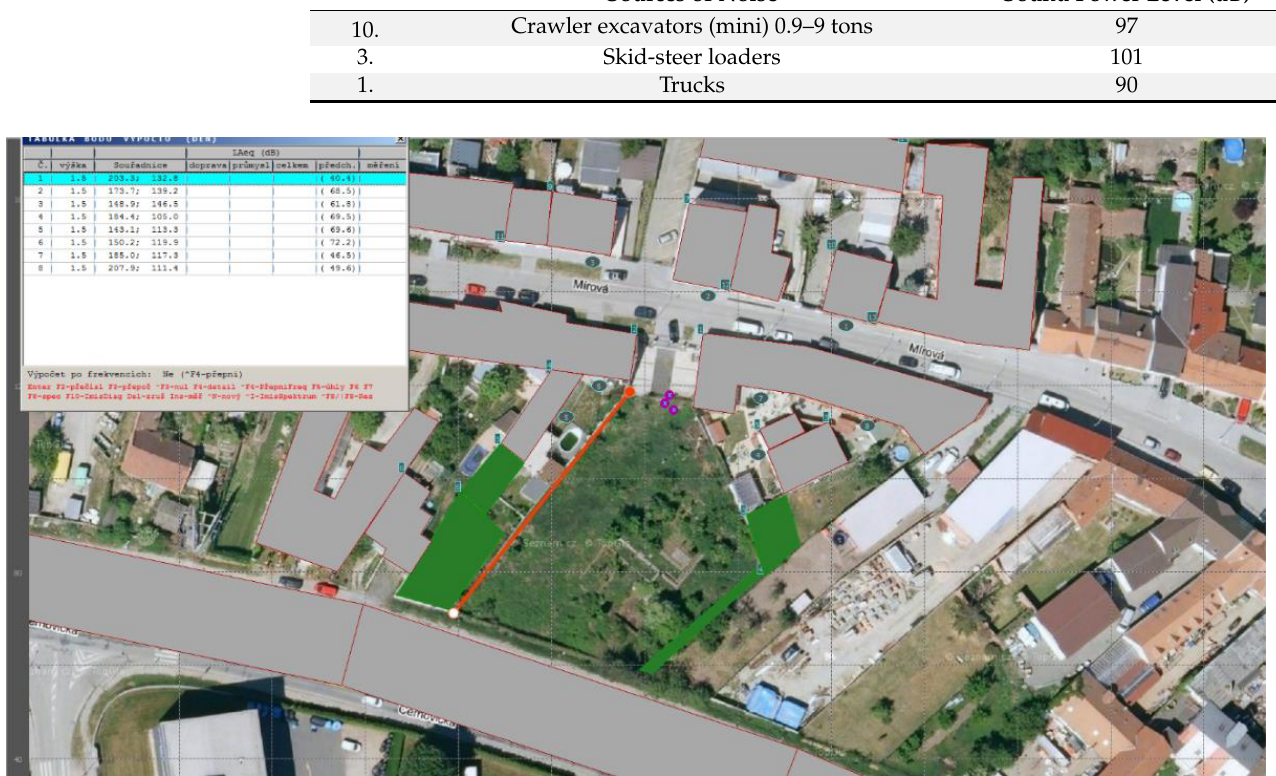
Figure 8. Acoustically significant elements (without construction site fencing or a solid gate) for earthworks during the construction of connections in the investigated area, with a table of values for the simultaneous deployment of machines. Table 8. Table of calculated values of measured points for earthworks during the execution of connections in the investigated area, with the simultaneous deployment of machines.